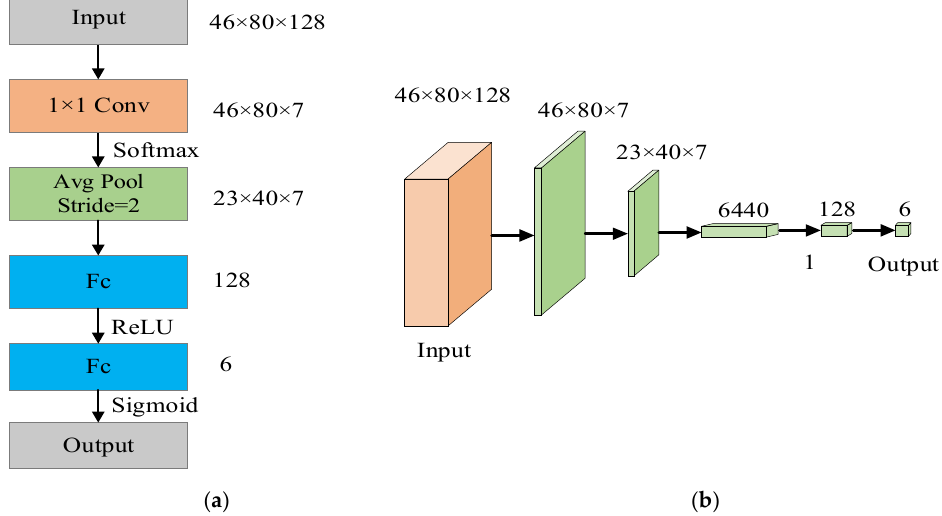
Figure 7. Lane line prediction branch. ( a ) Internal structure of lane line prediction branch. ( b ) External structure of lane line prediction branch.